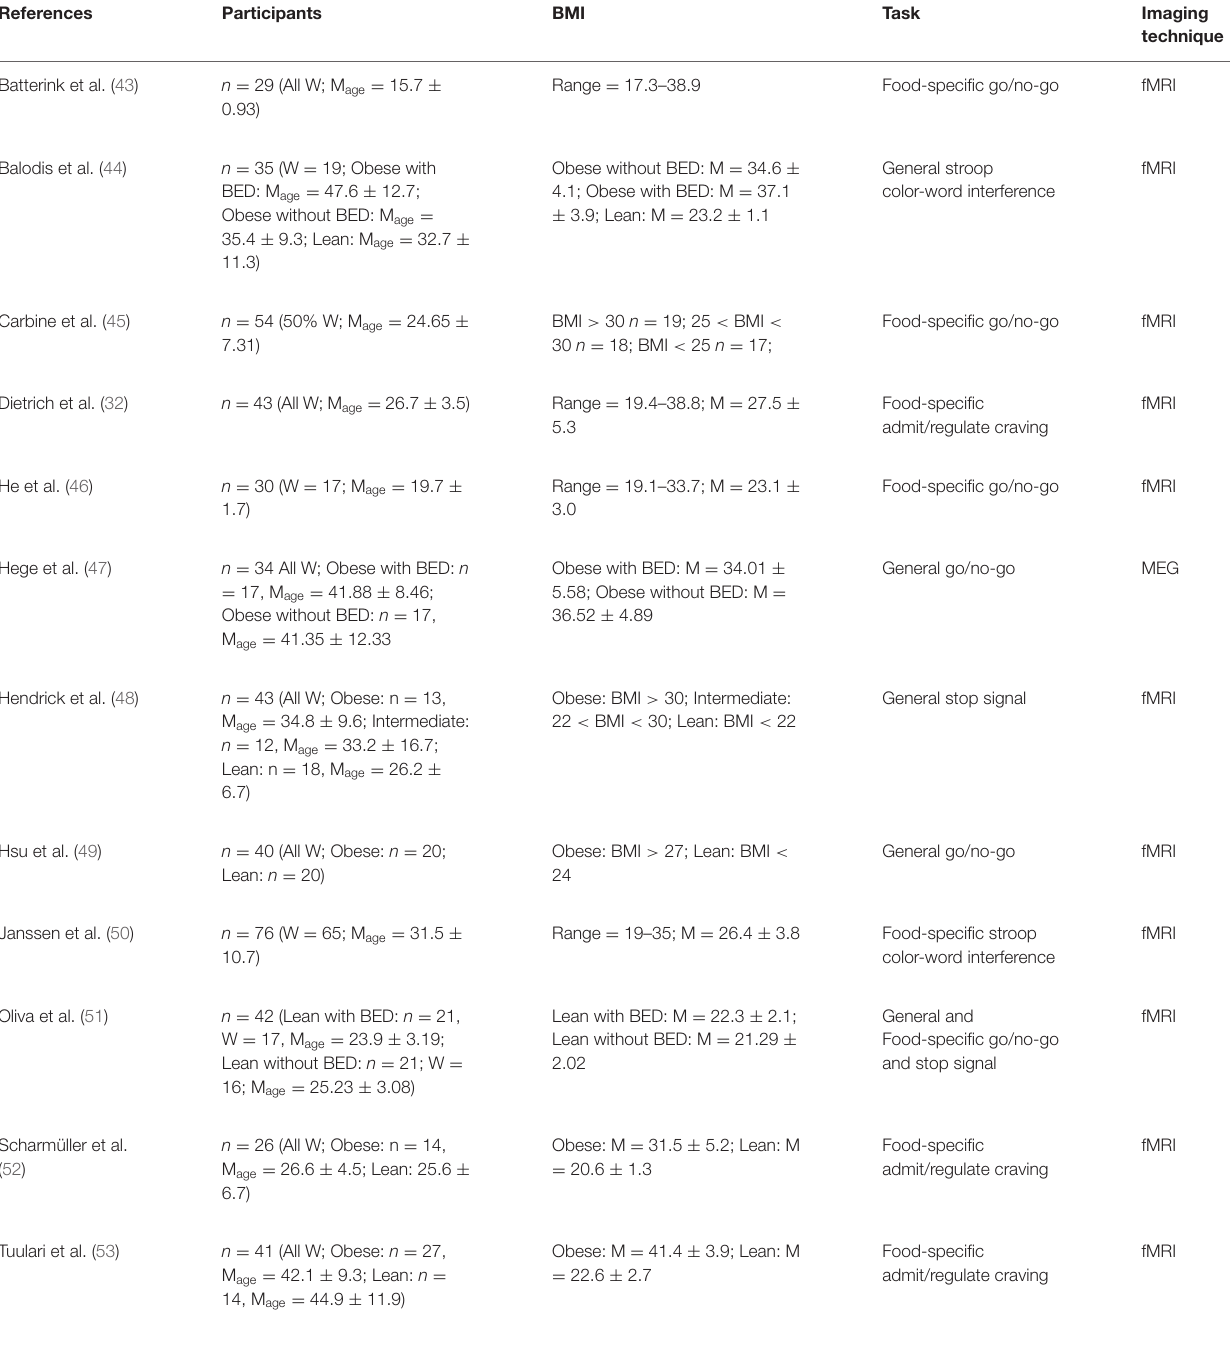
TABLE 1 | Neuroimaging studies assessing inhibition in obese in comparison with lean individuals. Participants BMI Task Imaging